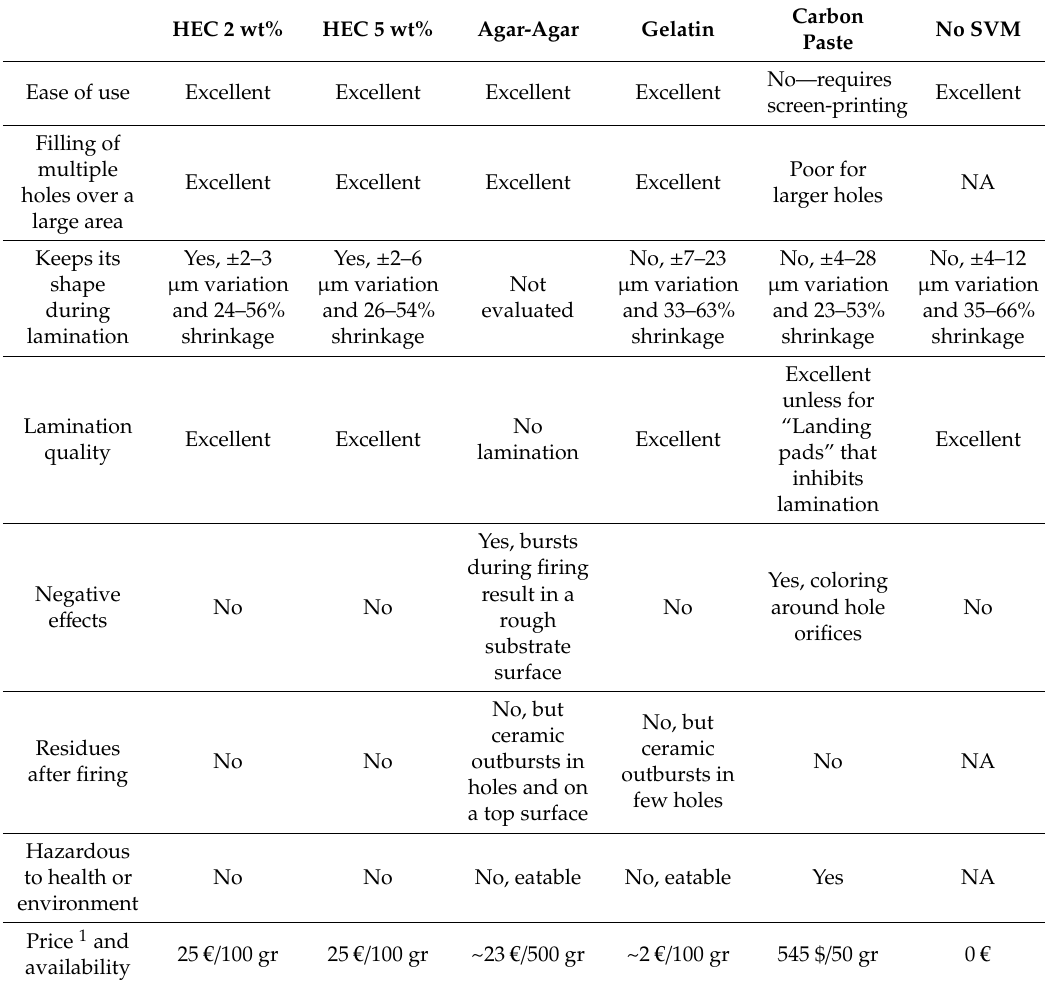
Table 4. Comparison of results as compared to the initial